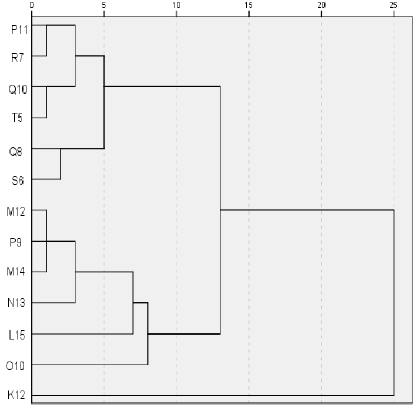
Figure 8. Cluster analysis of sampling sites in the dry season.